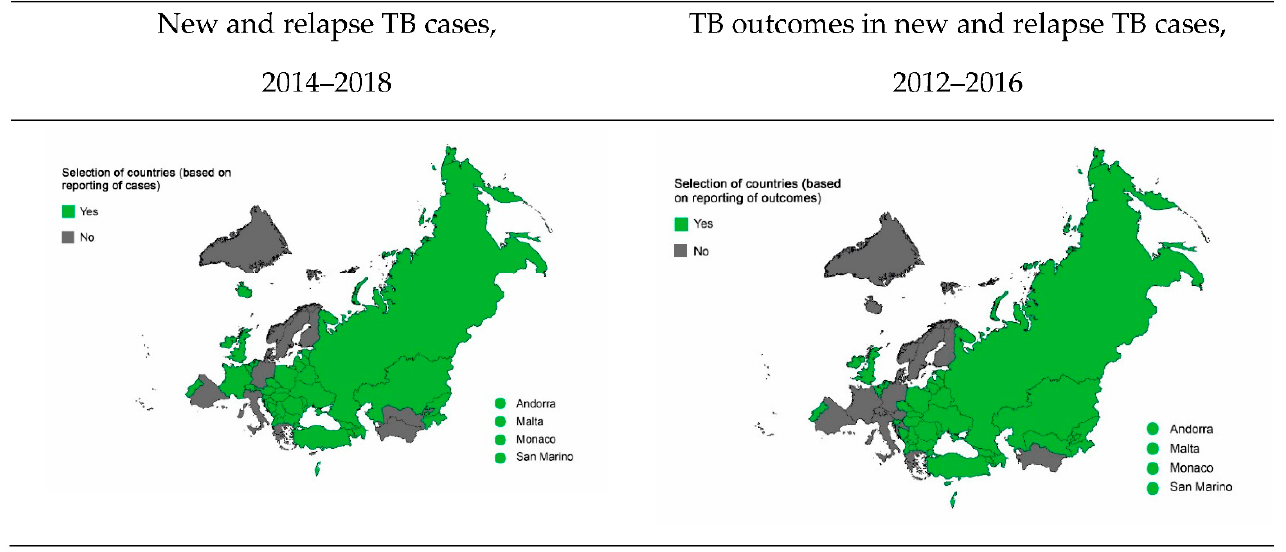
Table 2. Notification rate of incident TB cases and year-to-year percentage changes in TB notification rates, WHO European Region,